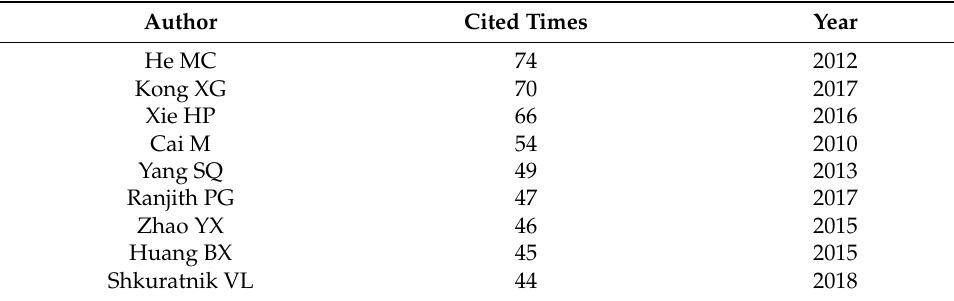
Figure 12. Author co-citation network. Table 6. The dates of each cited author.